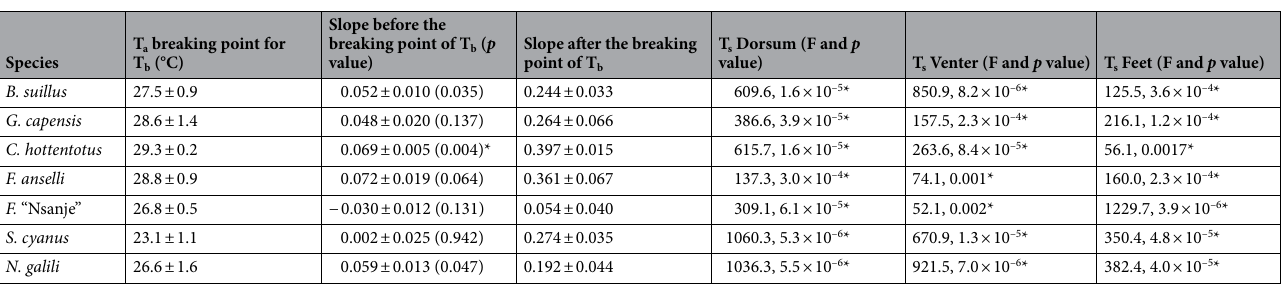
Table 2. Results of piecewise linear regressions characterising a change in core body temperature (T b ) and linear regressions characterising a change in the surface temperature (T s ) for three body regions in response to increasing ambient temperature (T a ) in seven subterranean rodent species. Breaking points and slopes are provided as mean ± SEM; p values for the slopes before the breaking point are in parentheses; statistically significant tests after the Bonferroni procedure α = 0.0071 for T b and α = 0.0024 for T s are marked with